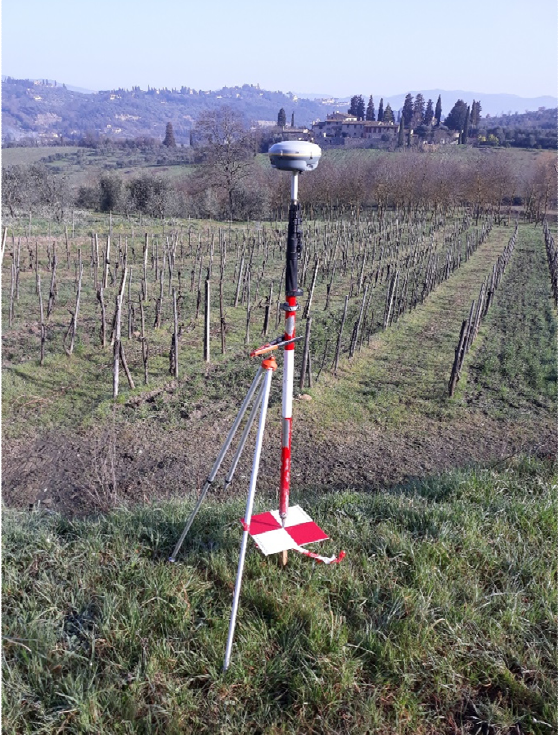
Figure 2. Measuring session of a ground target with pole, GNSS antenna and